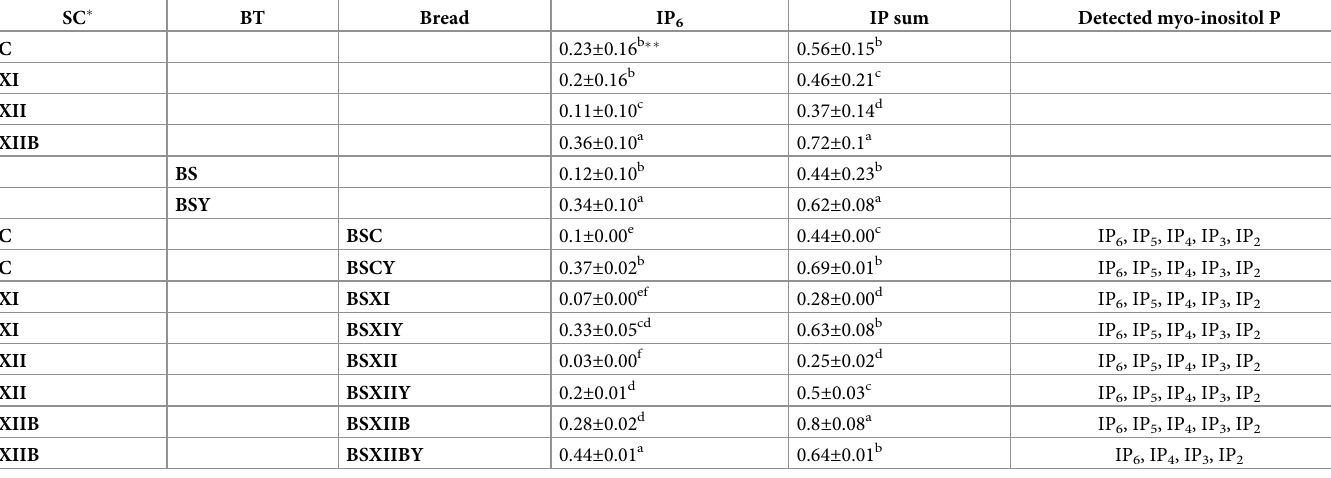
formation of resistant starch fraction RS [63]. As is known, the predominance of LAB during 3 dough fermentation restricts the starch retrogradation process in bread [59]. Dough prepared with the use of starter culture only (without the yeast addition) resulted in a significantly reduced the sum of myo-inositol phosphates in breads, i.e. from 1.5 to approxi- mately 5 times as compared to the applied raw material (Table 6), i.e. wholemeal rye flour, in which the total content of inositol phosphates was 1.18% db. The smallest amount of inositol hexakisphosphate (IP ) was determined in a bread BSXI and BSXII—0.07 and 0.03%. of bread 6 Table 6. Myo-inositol phosphate content in breads [%,